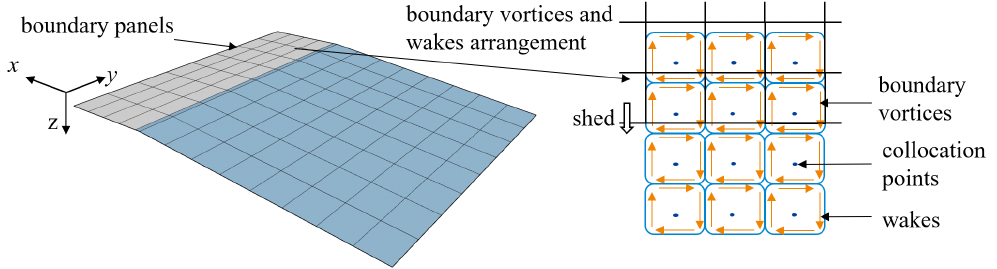
Figure 2. The sketch of the vortex ring